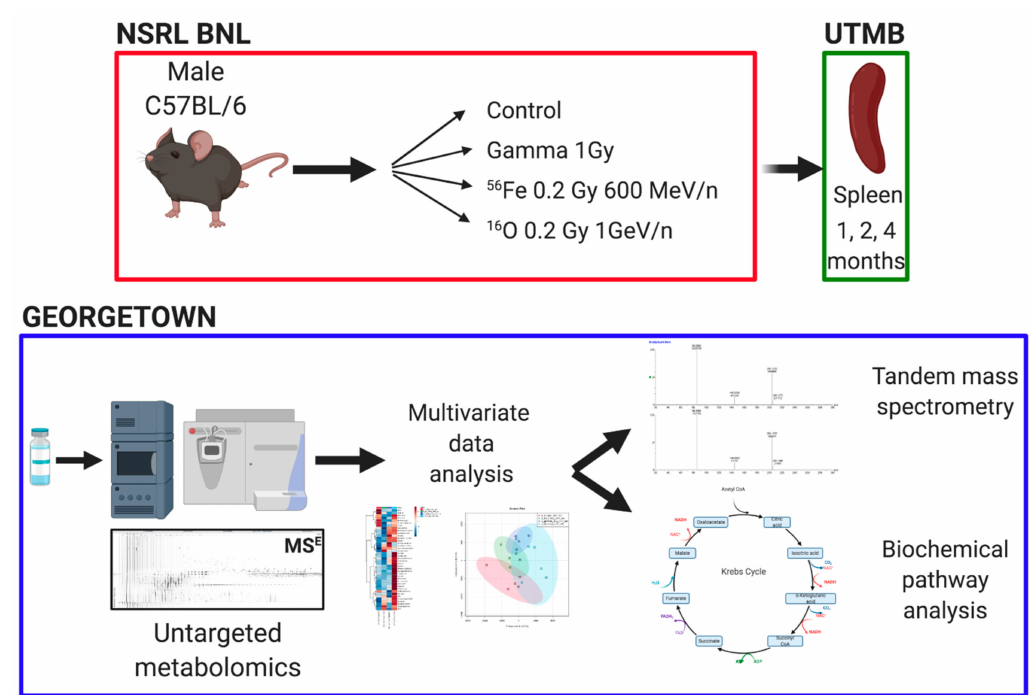
Figure 1. Experimental design. C57BL/6 were exposed to HZE particle irradiations or γ -rays at the NASA Space Radiation Laboratory at Brookhaven National lab. Spleen samples were collected at University of Texas Medical Branch and shipped to Georgetown University, where untargeted metabolomics and data analyses were conducted. Figure was created with BioRender.com (accessed on 25 January